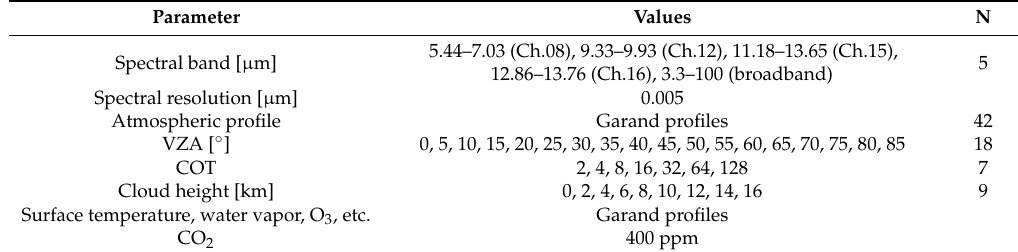
Table 4. Radiative transfer model setting options used to calculate